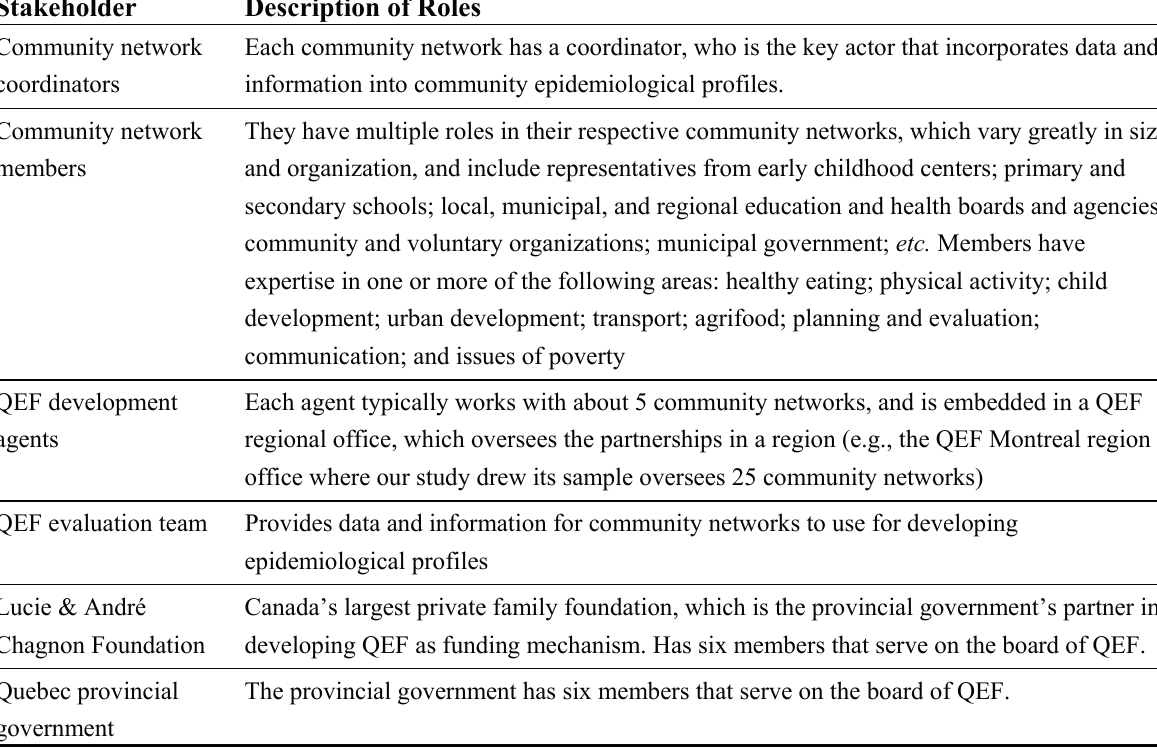
Table 4. Stakeholders and roles in QEF-funded community